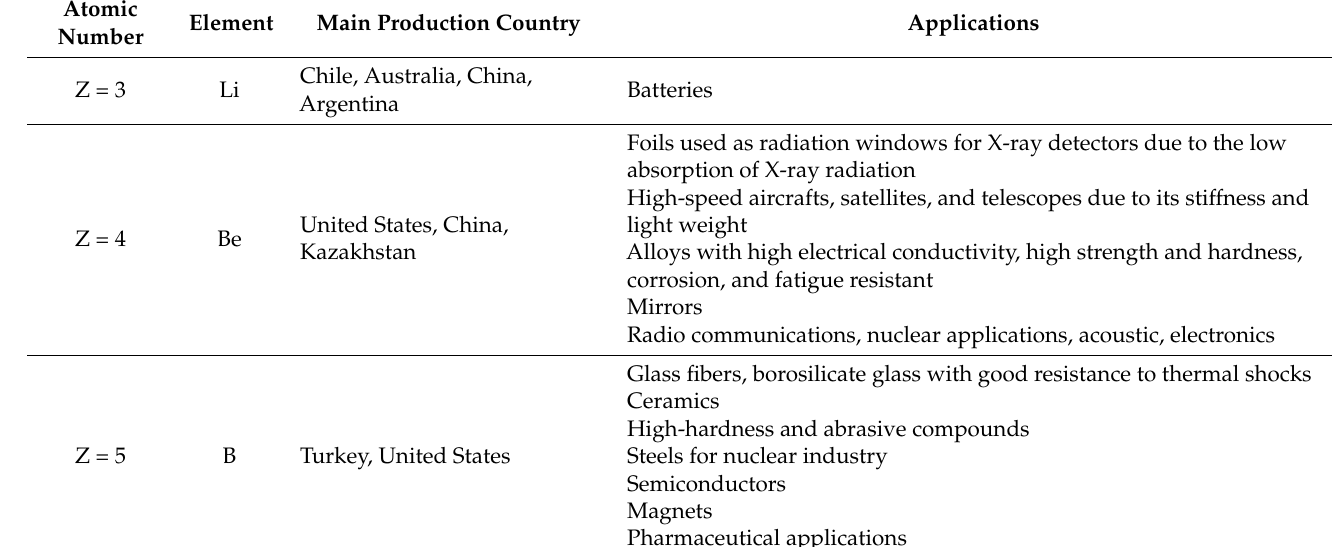
Table 1. A selection of the most economically important raw materials, mostly CRMs, listed in order of ascending atomic number